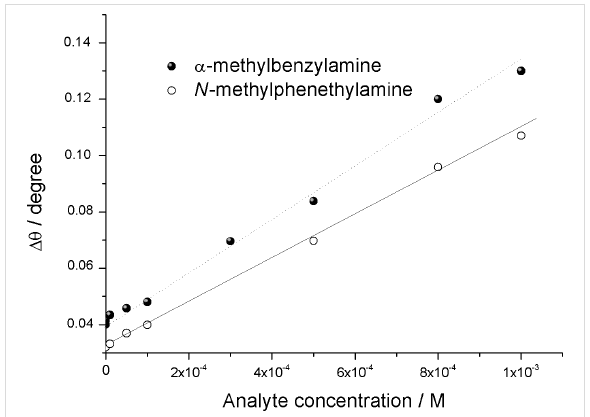
film, previously exposed to aniline, was treated for 15 min at 50 °C and then washed with a flow of ultrapure water for 5 min.